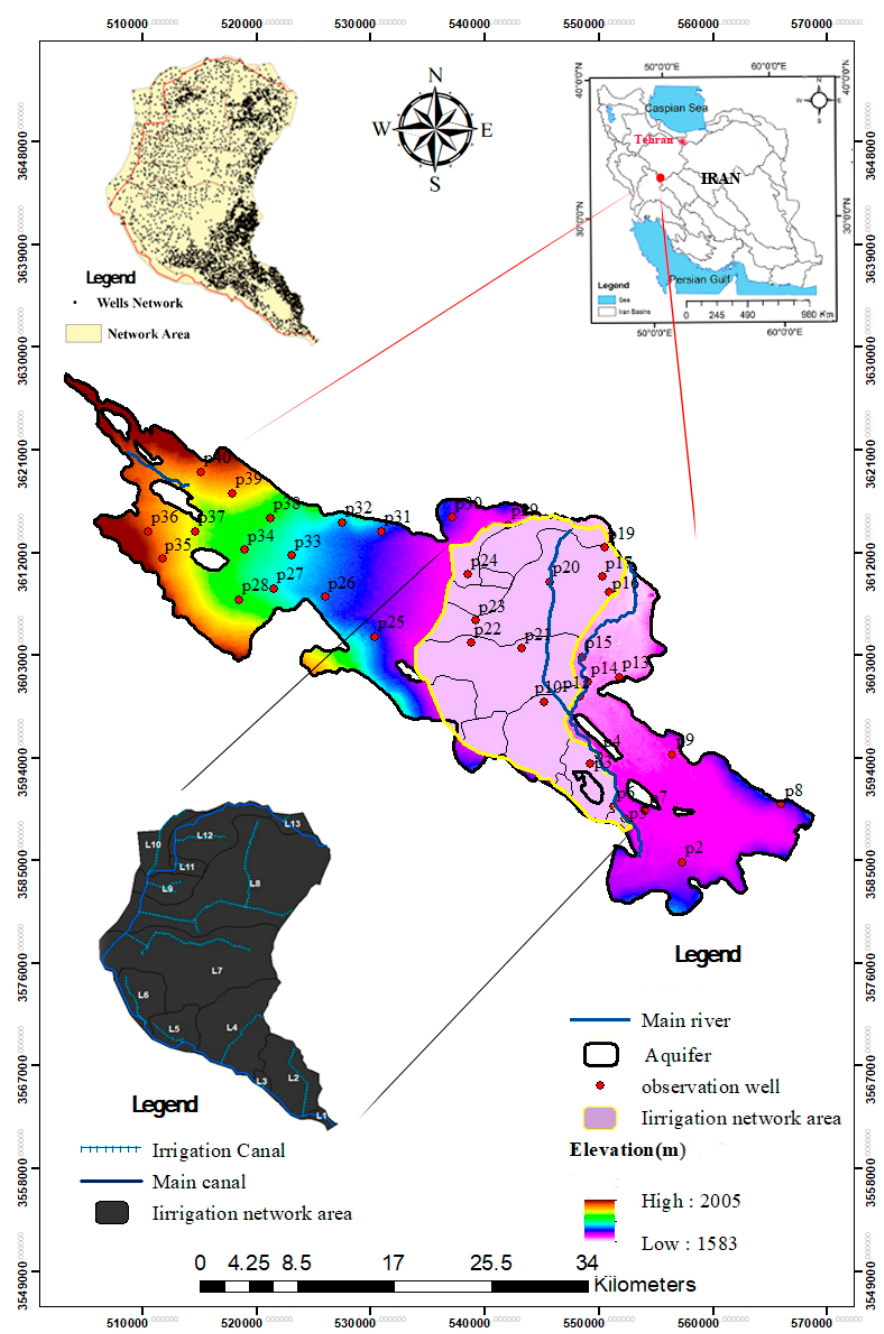
Figure 1. Location of the study area and the investigated aquifer.